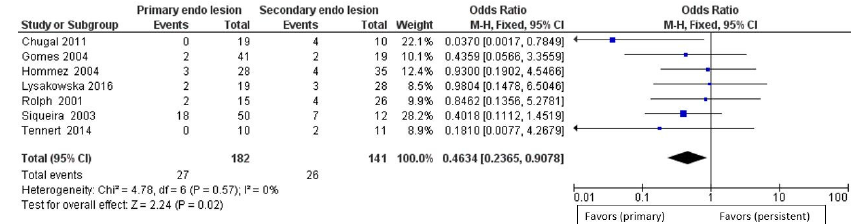
Figure 6. Forest plot of the fixed effects model of the meta-analysis of the secondary outcome.